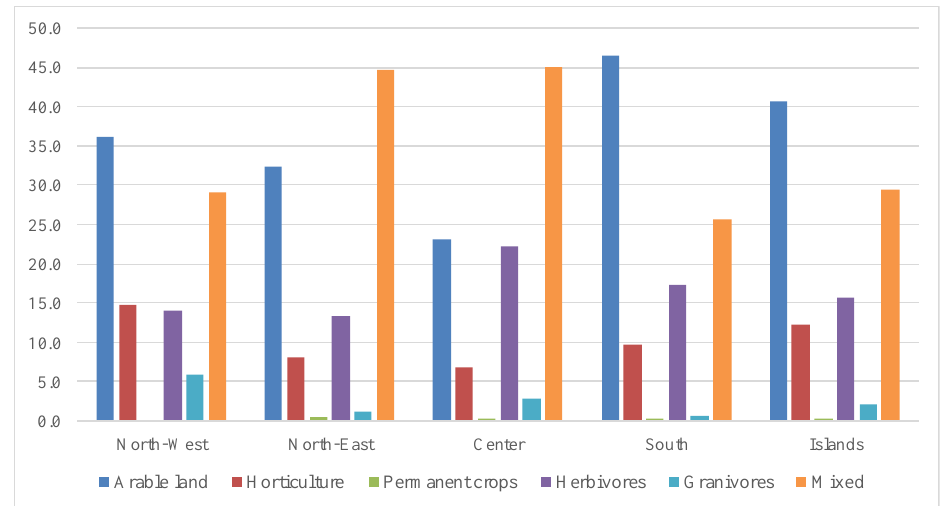
Figure 3. Percentage distribution of small farms by type of farming and district. Source: Our elabo- ration on FADN data, 2018 – 2020.